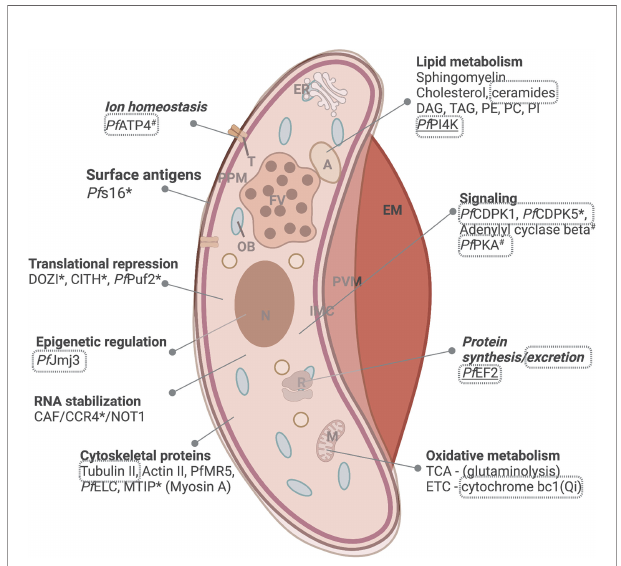
FIGURE 3 | Distinct biology associated with mature gametocytes. Processes of importance include lipid metabolism, protein synthesis, signaling and oxidative metabolism, including mitochondrial respiration. Proteins that are essential to parasite survival (www.phenoPlasm.org) are indicated by a * (for gametocytes) or # (for ABS stages) and those indicated as druggable by chemical inhibition are indicated in grey bordered text. Genes refractory to manipulation indicating essentiality are underlined. EM, erythrocyte membrane; PVM, parasitophorous vacuole membrane; IMC, inner membrane complex; ER, Endoplasmic reticulum; A, acidocalcisome; OB, osmiophillic body; T, transporter; PPM, parasite plasma membrane; FV, food vacuole; N, nucleus; M, mitochondrion and R, ribosome. Protein names are explained in text. Created and modi fi ed with